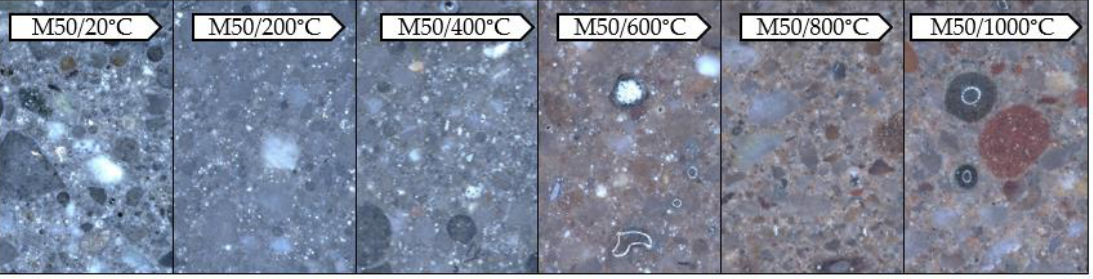
Figure 7. Photos taken with the Keyence VHX-7000 digital microscope, 50 × magnification, mortar with GGBFS.